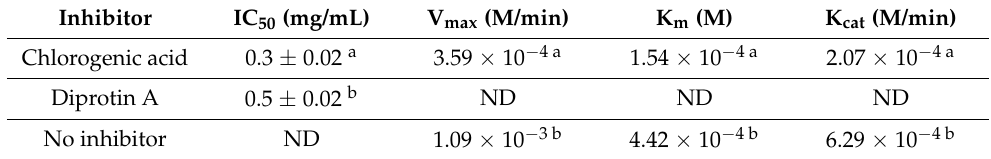
Table 5. Inhibitory effect (IC 50 ) and enzyme kinetic parameters of chlorogenic acid against